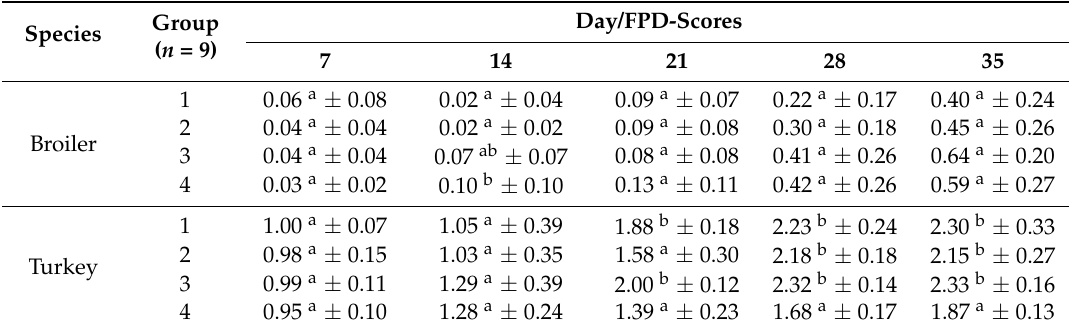
Table 4. Development of external foot pad scores (FPD) in broilers and turkeys kept on four different flooring designs throughout the experimental period (mean ±